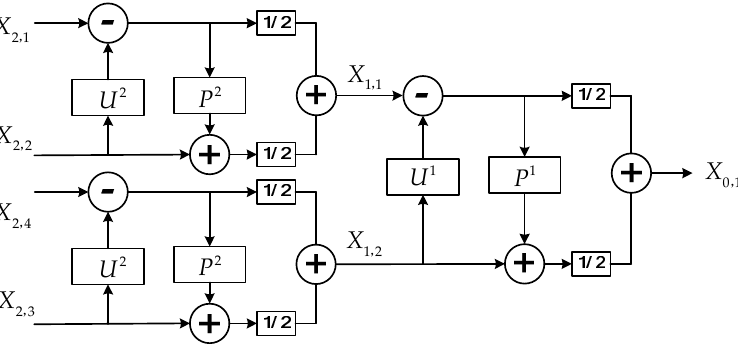
Figure 3. An example of two levels RSGWPT reconstruction stage.